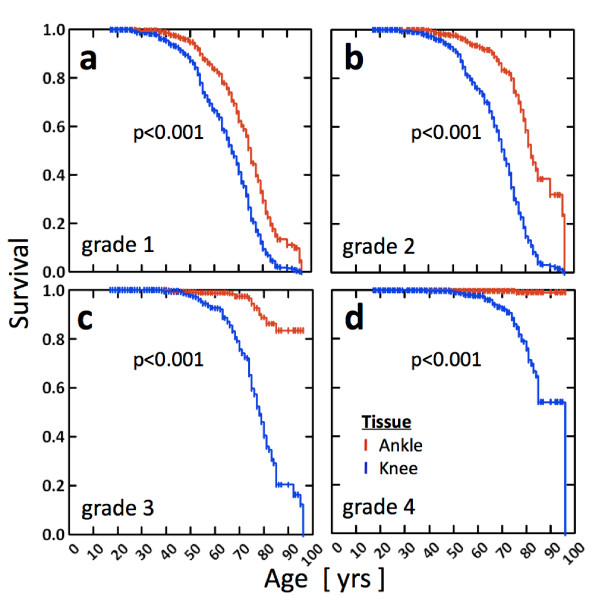
Survival curves of the ankle (red) and the knee (blue), reflecting the probability of samples attaining grades (a) 1, (b) 2, (c) 3 or (d) 4. There is a significant difference between expected survival of knees and ankles (P = 0.001).